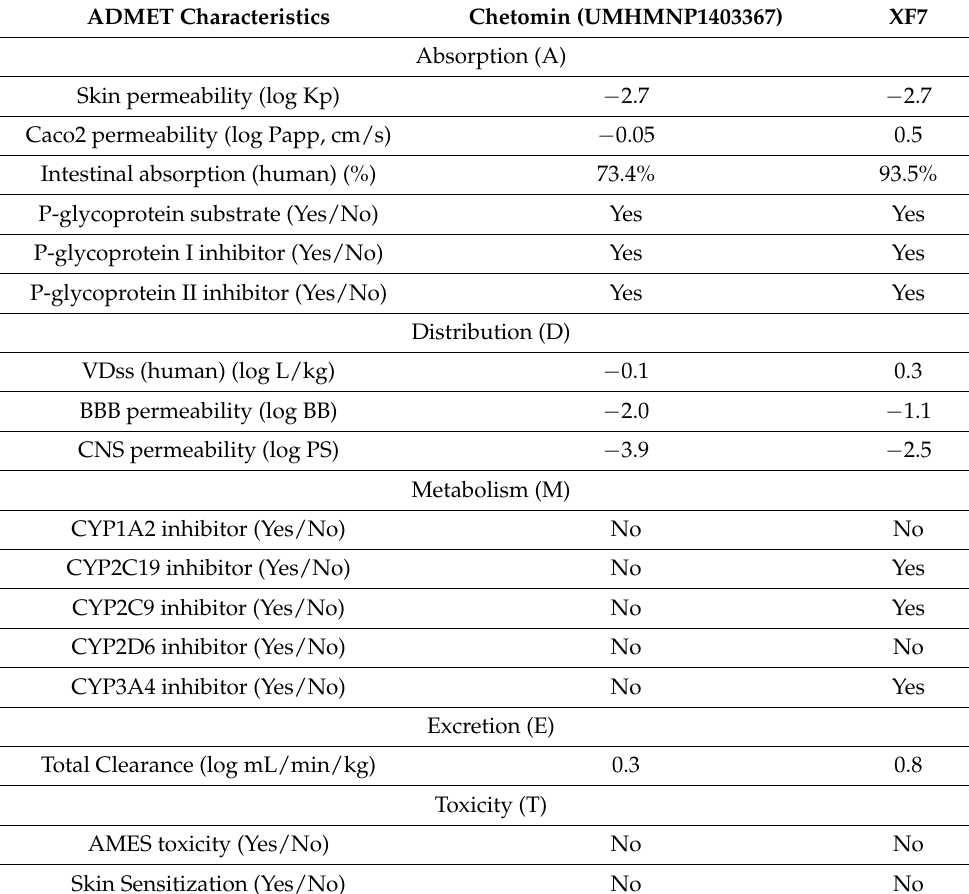
Table 3. The ADMET anticipation for chetomin (UMHMNP1403367) and XF7 as anti-COVID-19 drug